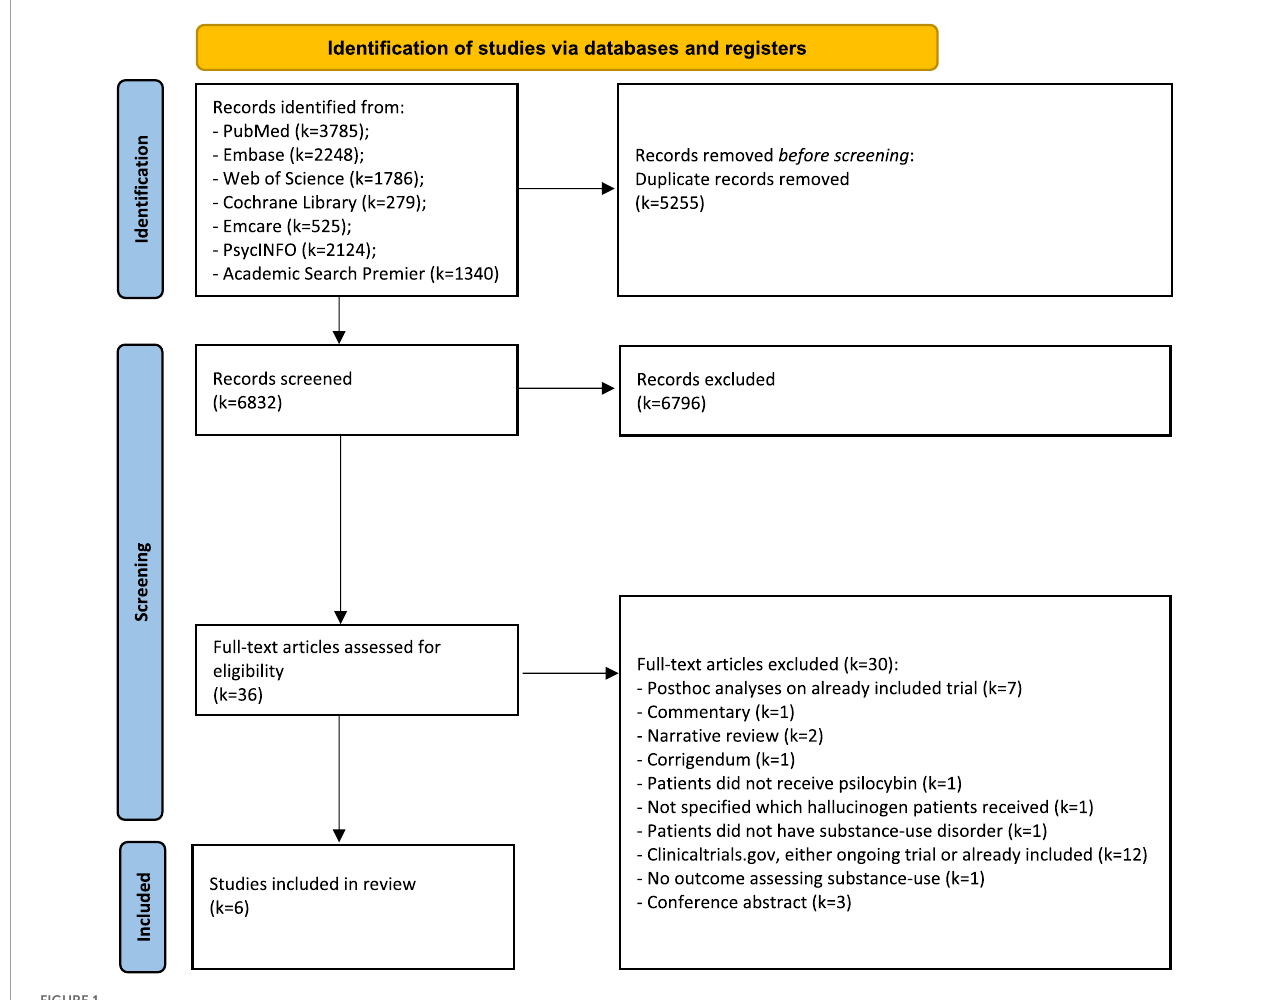
FIGURE1 Flowchart of identified records and eventually included clinical